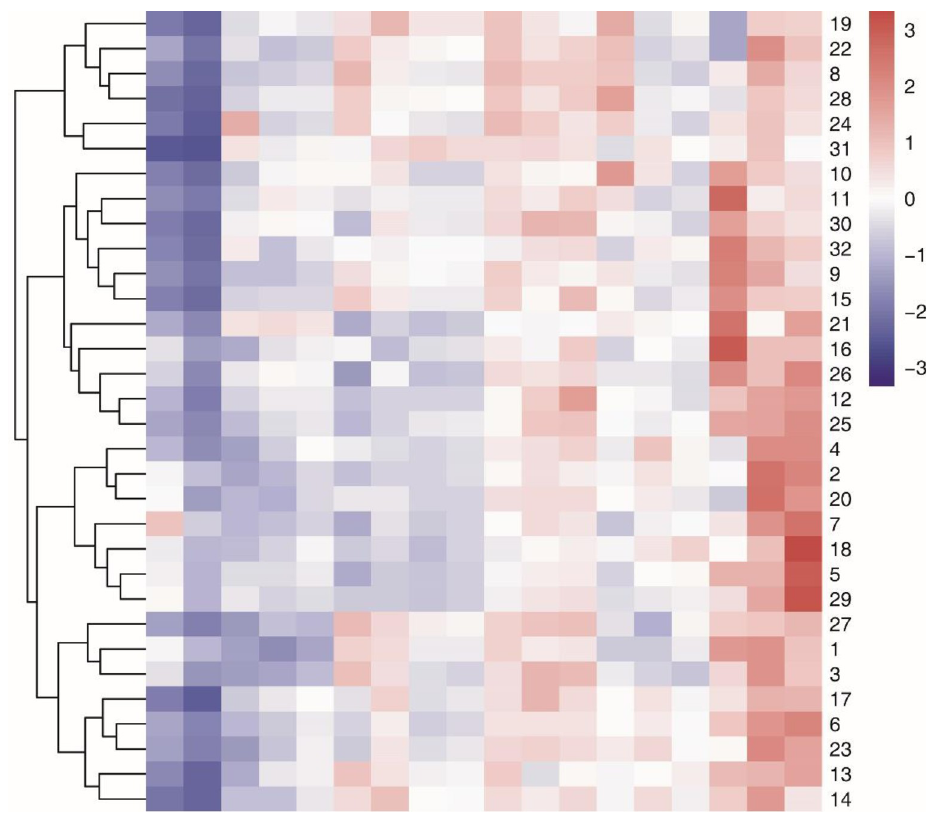
Fig 1. System clustering of tolerance to low Fe stress in 32 maize hybrids. The number represents the serial number of cultivars in S1 Table.